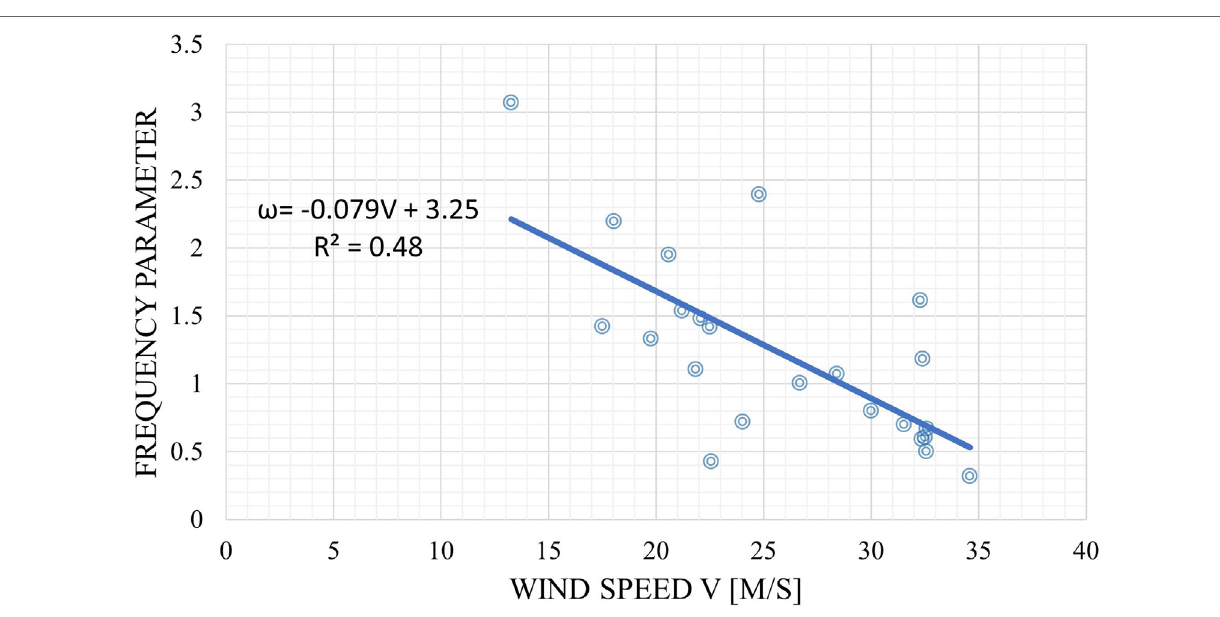
FigUre 7 | Relationship between the frequency parameter and wind speed V for Hurricane Isaac at the parish